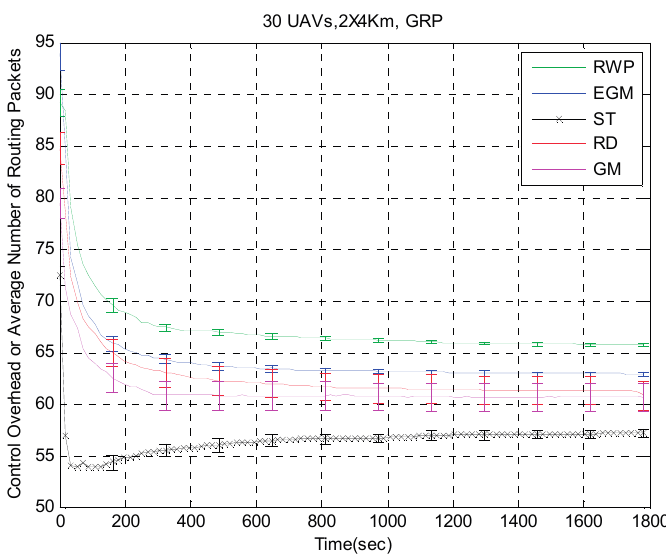
Figure 12. Routing overhead of GRP under various mobility models.